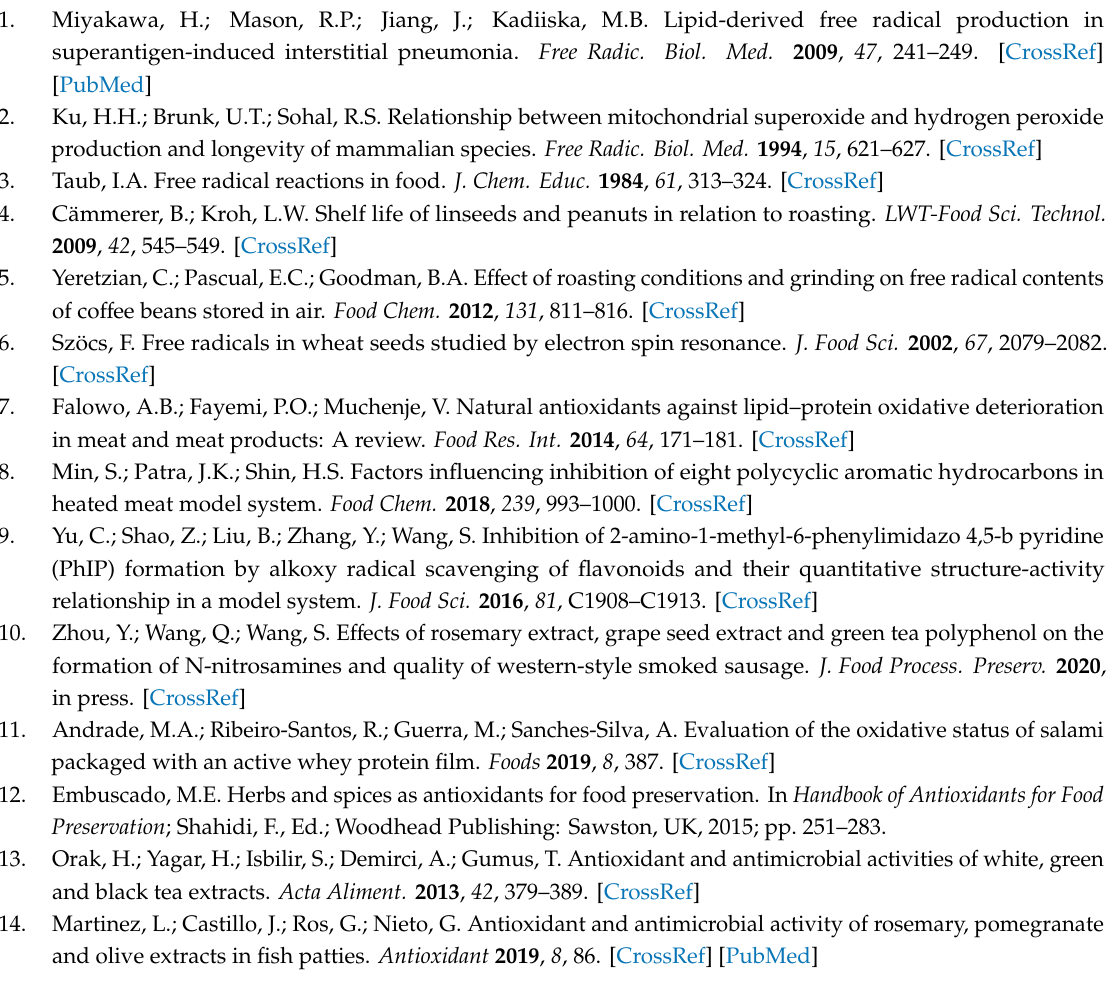
Table S1: Analysis for di ff erent temperature, water content, and their interaction on radical content. Table S2: Characterizations of the raw beef, pork, chicken breast and thigh by the total lipid, total myoglobin, fatty acid and radical concentrations